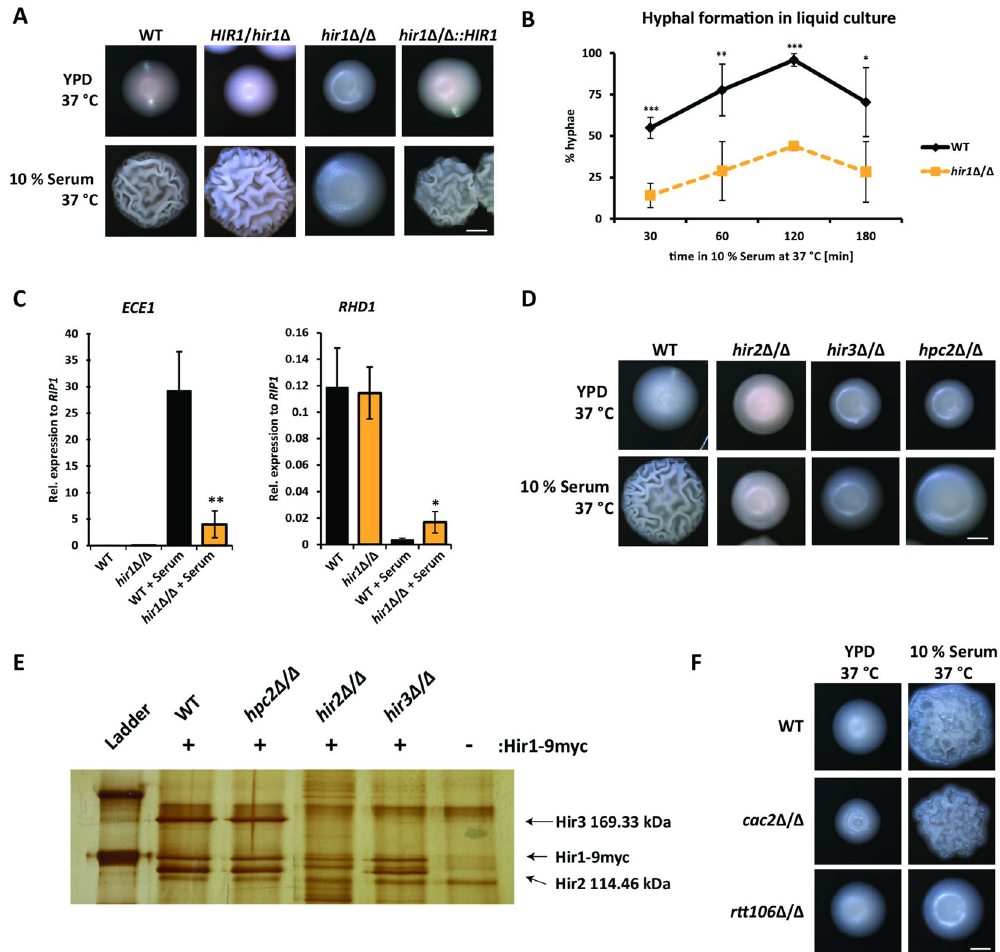
Figure 1. Regulation of hyphal formation by the HIR complex. ( A ) hir1 Δ / Δ cells are defective in serum- induced hyphal formation on solid medium. Colony morphology was inspected after 3 days. Scale bar corresponds to 1 mm. ( B ) Loss of HIR1 decreases hyphal formation in liquid medium. Hyphal formation of WT and hir1 Δ / Δ cells was evaluated in YPD supplemented with 10% FCS at 37 °C after the indicated time points. ( C ) Hir1 controls hyphal-specific gene (HSG) expression. ECE1 and RHD1 gene expression was measured after 30 min of hyphal induction via RT-qPCR. Transcript levels were normalized to the expression of the reference gene RIP1 22 . ( D ) HIR complex mutants display decreased hyphal formation. Colony morphology of hpc2 Δ / Δ , hir2 Δ / Δ and hir3 Δ / Δ was examined as in ( A ). Scale bar corresponds to 1 mm. ( E ) Hir1 associates with Hir2 and Hir3 in C . albicans . Hir1 was epitope-tagged with 9myc in either WT background or in strains lacking one HIR complex component and subjected to native immunoprecipitation. Precipitated proteins were separated through a 10% SDS-PAGE gel and visualized by silver staining. Detected protein bands were cut out and identified via mass spectrometry analysis. The indicated molecular weight for Hir3 and Hir2 are derived from mass spectrometry analysis. ( F ) Hyphal formation is Cac2-independent. Colony morphology of WT cells and cells lacking CAC2 and RTT106 was analyzed as above ( A ). Scale bar corresponds to 1 mm. ( B , C ) Data are presented as mean + SD of three independent experiments. For significance testing, hir1 Δ / Δ cells were compared to WT cells. n.s. not significant, * P < 0.05, ** P < 0.01, *** P < 0.001 with Student’s